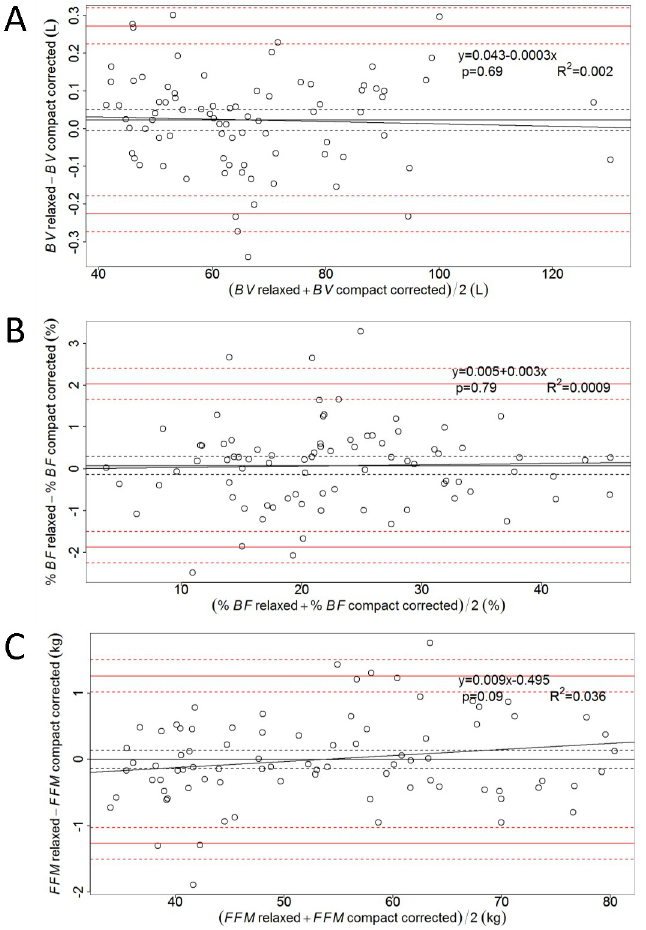
Fig 3. Bland-Altman plots for BV , %BF , and FFM derived from the corrected SAA corresponding to the compact position. Shown are plots of differences vs. means of BV (A), % BF (B), and FFM (C) obtained in relaxed position and compact position – with BV given by Eq